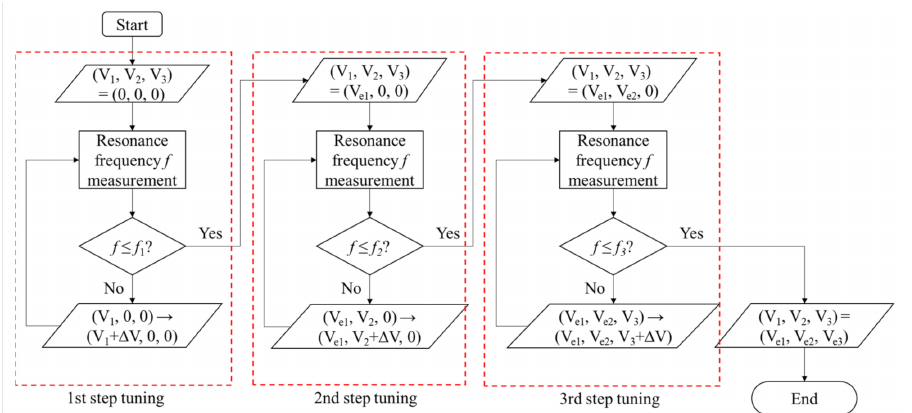
Figure 3. The flow chart of multi-step electrical tuning. Voltages V 1 , V 2 , V 3 are the voltages applied to 1st, 2nd, 3rd step tuning electrodes, respectively. And f 1 , f 2 , f 3 are the target resonance frequencies of each step. We set f 1 = 8.0 Hz, f 2 = 1.9 Hz, f 3 = 0.4 Hz for our